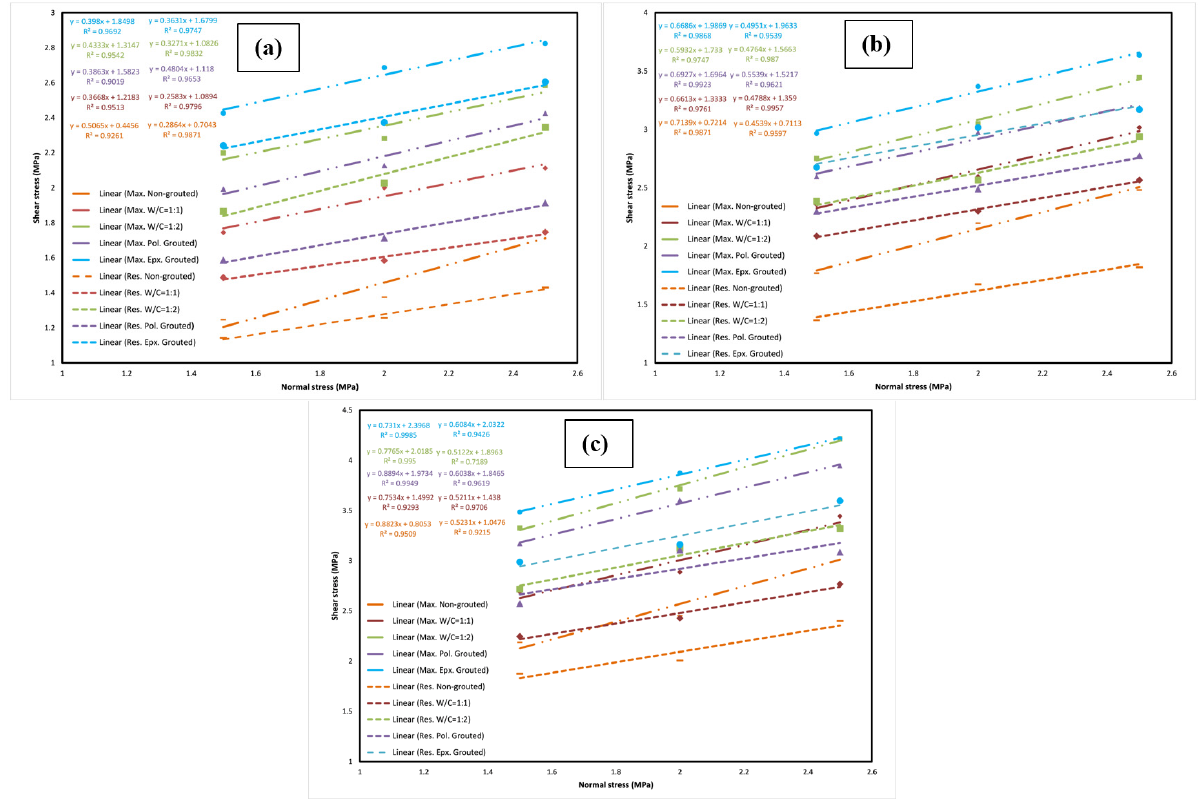
Figure 4. Shear stress-normal stress curves obtained for rock joints for ( a ) JRC = 7.8, ( b ) JRC = 12.6, ( c ) JRC = 17.4 .